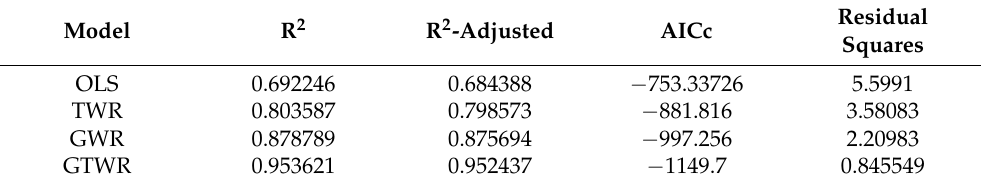
Table 4. Comparison of regression results of OLS, GWR, TWR, and GTWR